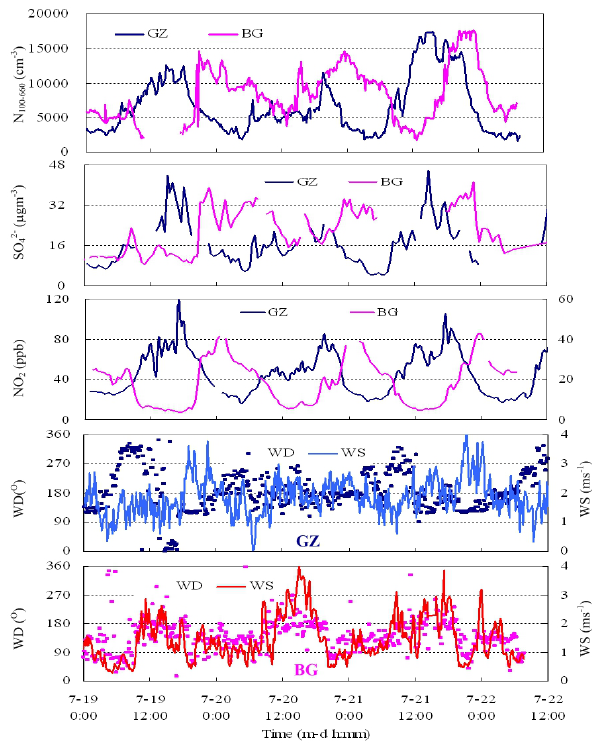
Fig. 5. Particle number concentrations from 100 to 660nm ( N 100 − 660 ), mass concentrations of SO 2 − and wind direction (WD) and wind speed (WS) from 19 to 22 July at GZ and